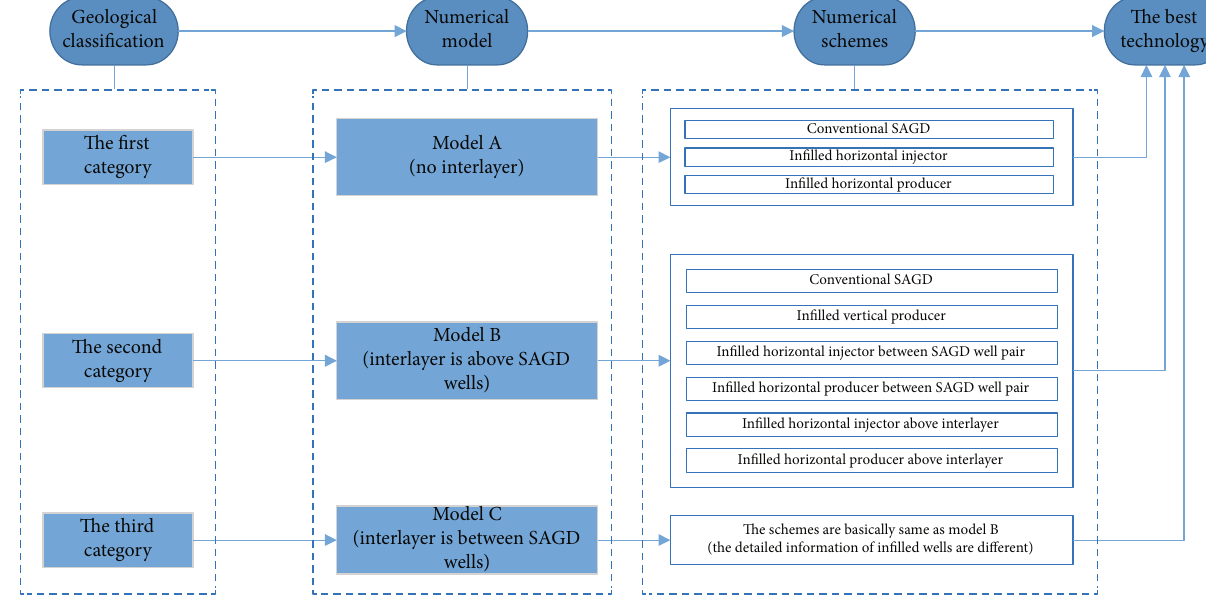
Figure 1: The fl ow chart of the problem under